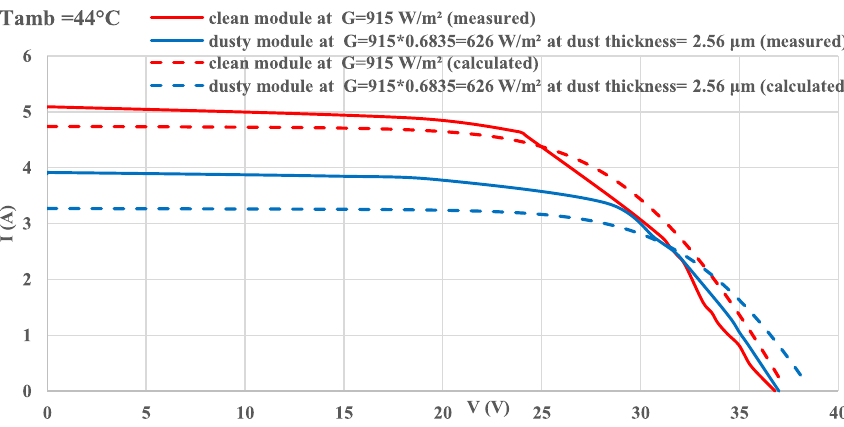
Fig. 9 Measured and calculated current–voltage characteristic curves of dusty and clean modules at ambient incident radiation of 915 W/m 2 https:// www. trnsys.